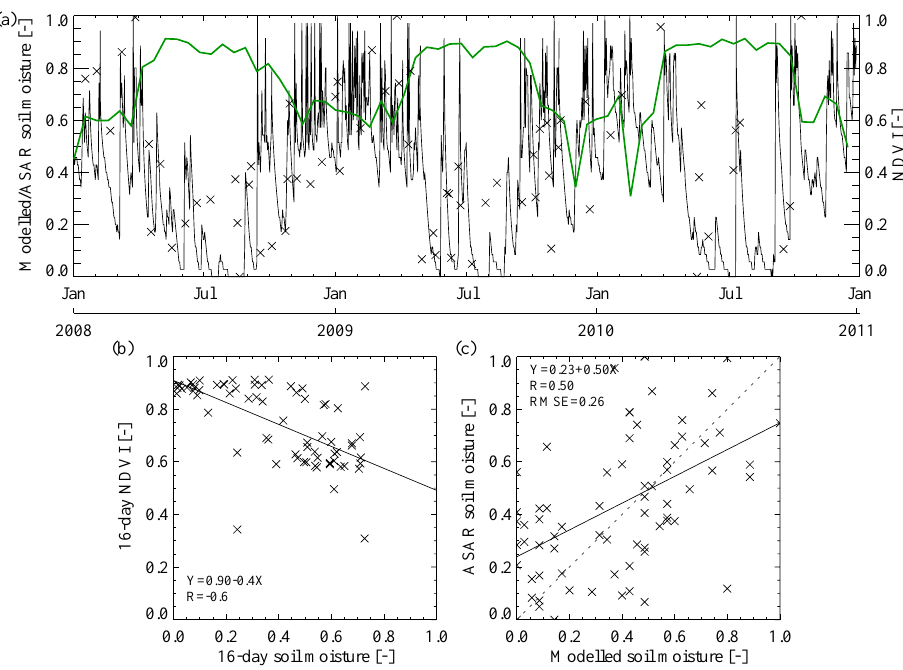
Fig. 6. Temporal behaviour of modelled soil moisture (black line), NDVI (thick green line) and ASAR soil moisture (crosses) for a pixel over deciduous forest (a) ; scatterplot of modelled soil moisture averaged over 16 days and 16-day NDVI for the same pixel (b) ; scatterplot of modelled soil moisture and ASAR soil moisture for the same pixel (c)